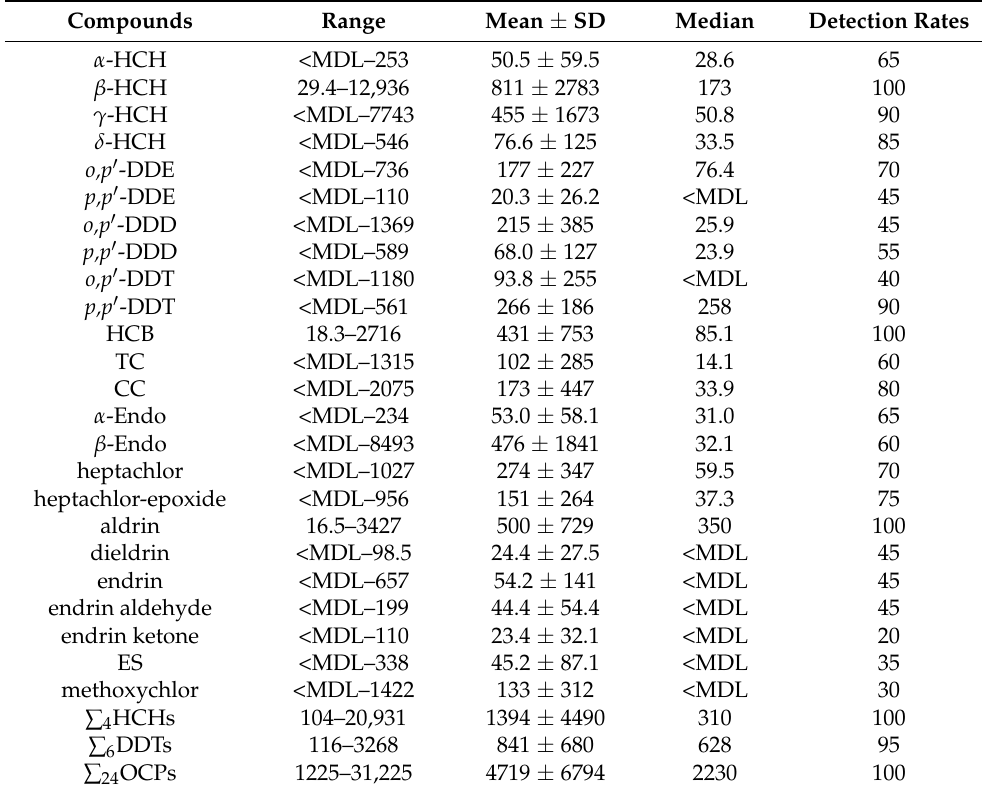
Table 1. Concentrations (pg · L − 1 ) and detection rates (%) of OCPs in the Danshui River. Compounds Range Mean ± SD